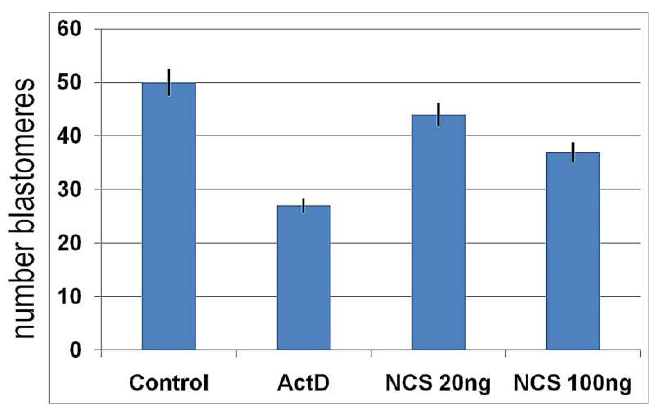
Figure 14. Quantification of TUNEL signal intensity in control, actinomycin D-treated blastocysts, and blastocysts after previous treatment with NCS during one-cell stage. The values show the average relative density of the fluorescent signal in the blastocyst of each experimental group.